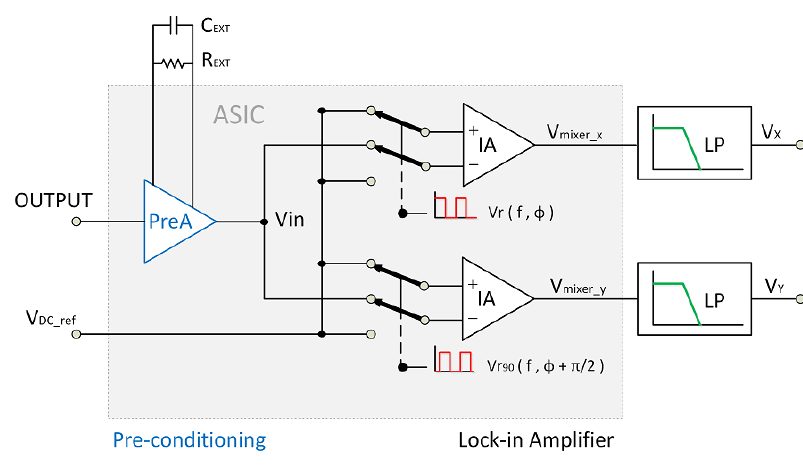
Figure 2. Block diagram of the signal conditioning stage.